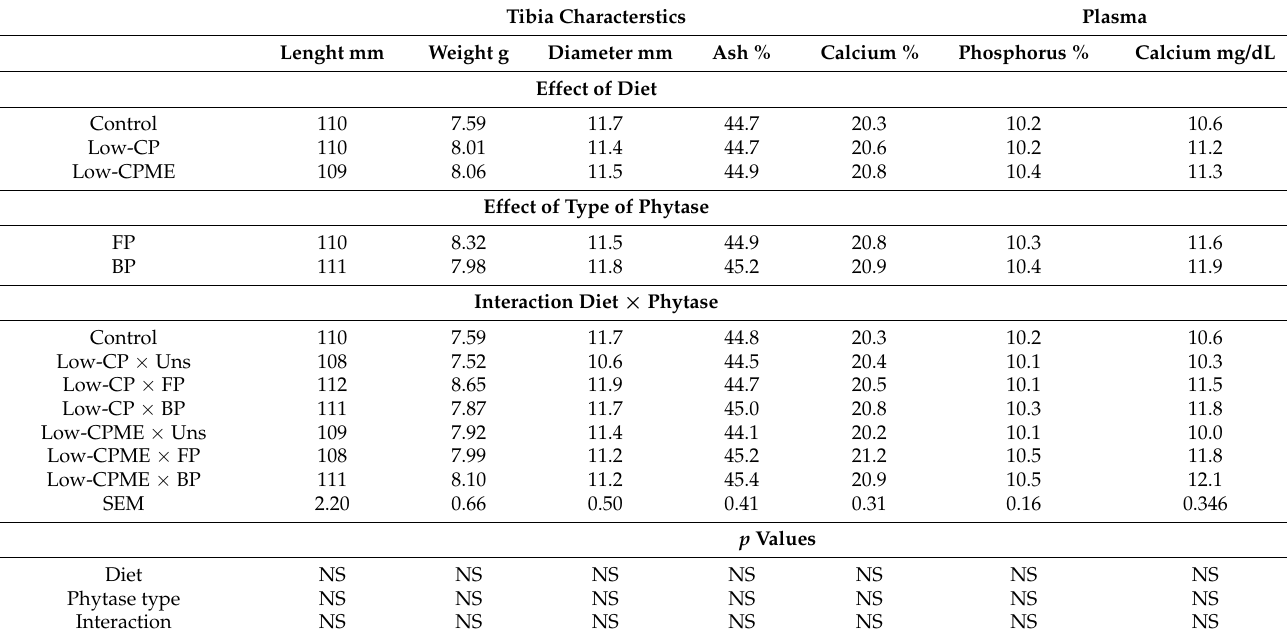
Table 5. Effect of diet, type of phytase and their interaction on tibia characteristics, and plasma calcium and inorganic phosphorus of